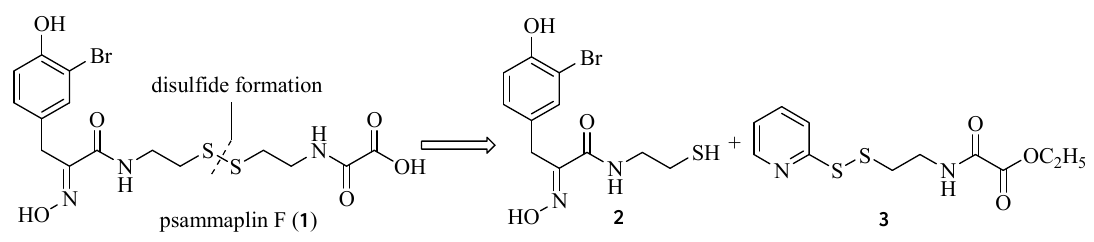
Figure 1. Retrosynthetic analysis of psammaplin F ( 1 ).